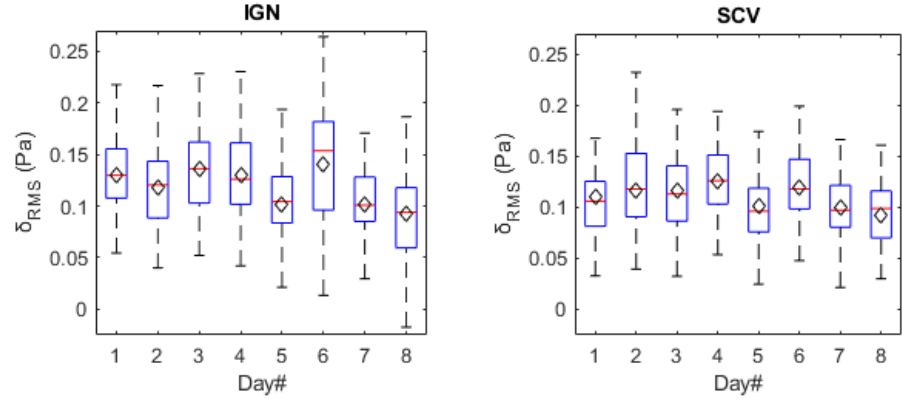
Figure 13. δ 𝑅𝑀𝑆 values computed for spark signals at sensor locations IGN and SCV.